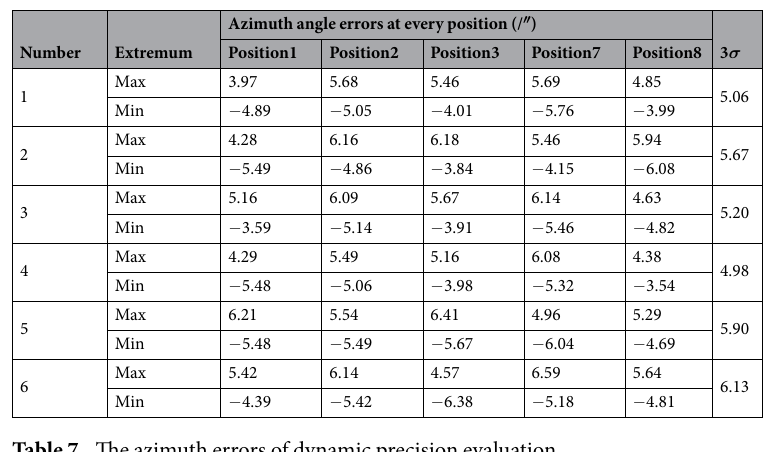
Table 7. The azimuth errors of dynamic precision evaluation.